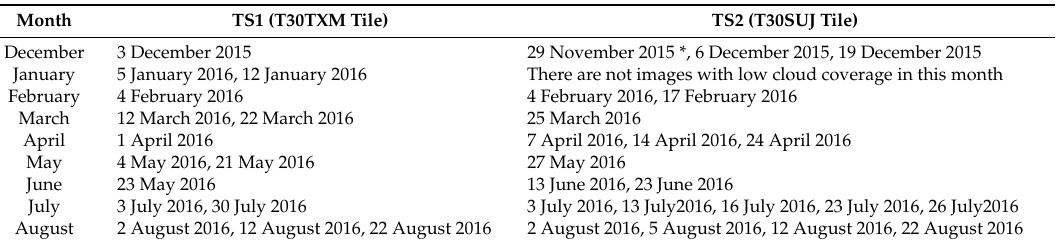
Table 2. Sensing date of the imagery used in the test sites. TS1, Test Site